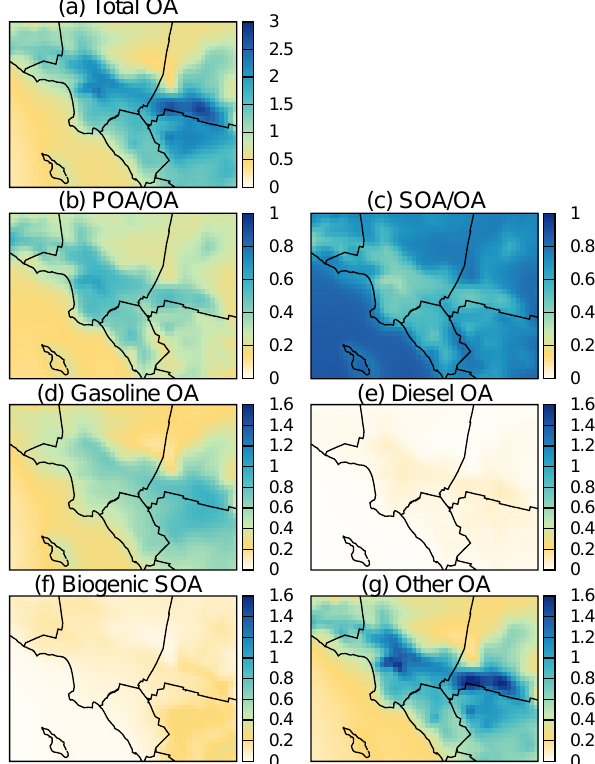
Figure 2. Averaged predictions from the VBS-IVOC model for (a) total OA (µgm − 3 ) , (b) POA fraction, (c) SOA fraction, (d) total gasoline OA (µgm − 3 ) , (e) total diesel OA (µgm − 3 ) , (f) biogenic SOA (µgm − 3 ) , and (g) other OA (µgm − 3 ) over southern Califor-